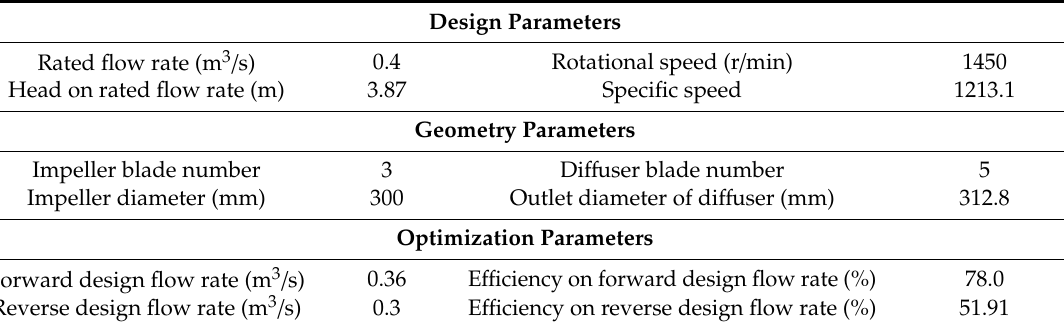
Figure 1. 3D model of the original design. Table 1. Main parameters of the original design.